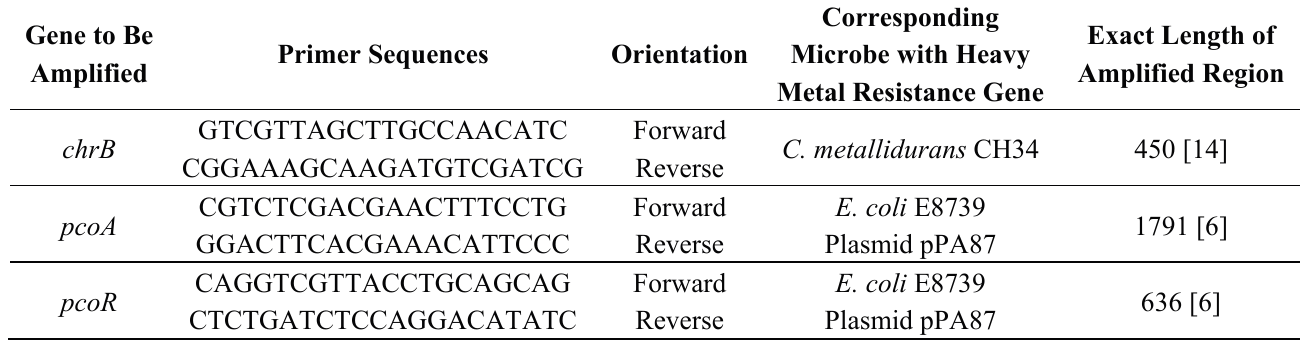
Table 6. Heavy metal resistance gene primers used in this